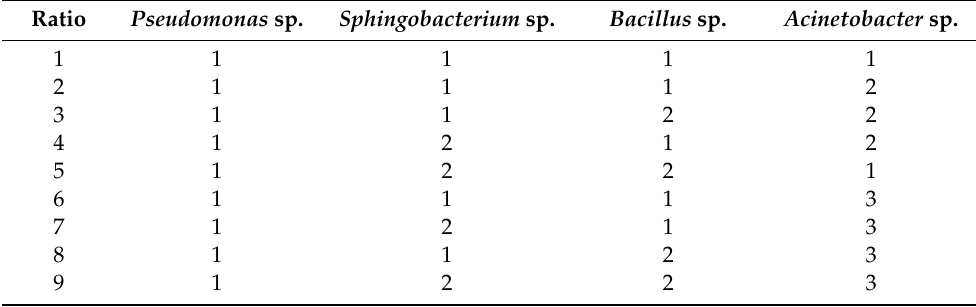
Table 1. The ratio of the synthetic microbial community. Ratio Pseudomonas sp. Sphingobacterium